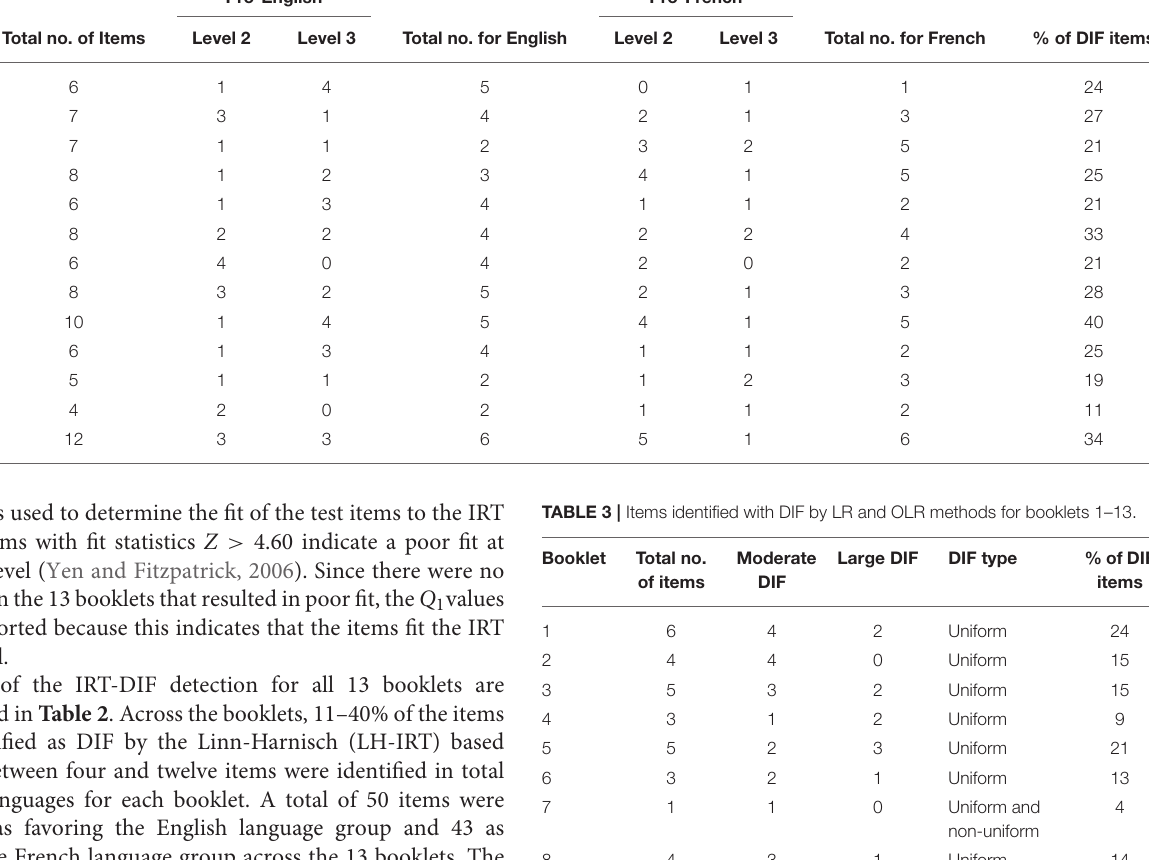
TABLE 2 | Number of DIF items detected by LH-IRT for booklets 1–13.